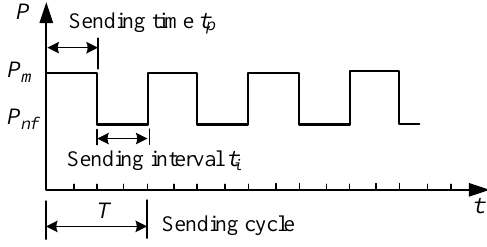
Figure 12. Transmission period model of nodes.